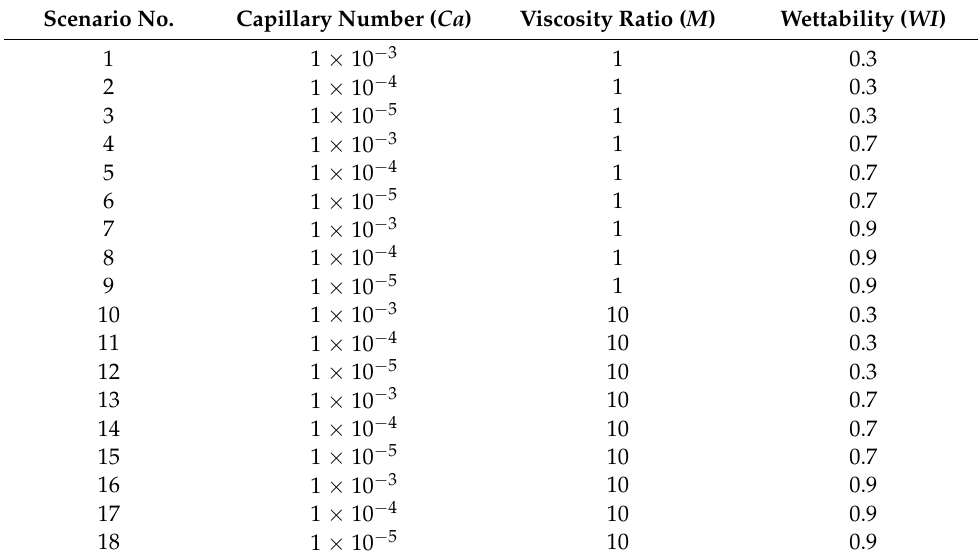
Table 1. All 18 scenarios constituting different combinations of three nondimensional parame- ters (capillary number ( Ca ), viscosity ratio ( M ) and wettability ( WI )) for two-phase CO 2 –brine imbibition processes.